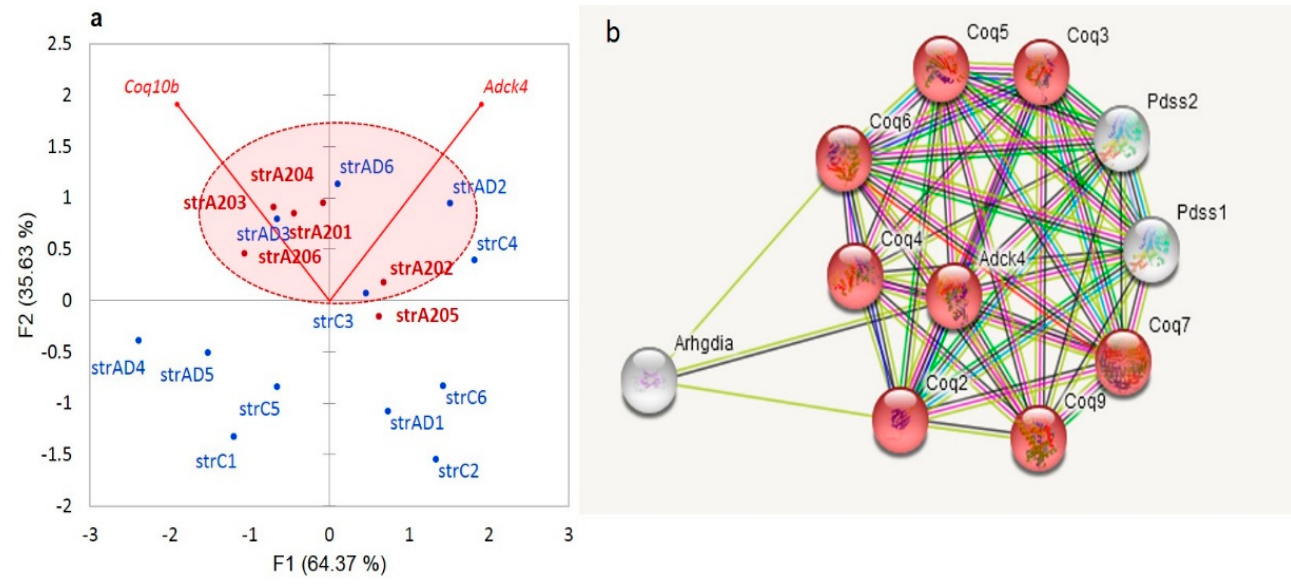
Figure 15. ( a ). The expression rate of CoQ10b , along with Adck4 ( Coq8b ), is elevated in the A20 group (encircled; random probability of five of six A20 mice located in the upper half is p < 0.01 based on a binomial test). ( b ). The gene network for Adck4 ( Coq8b ) according to string-db.org resource. Red shaded nodes relate to GO: 0005743: Mitochondrial inner membrane (8 of 435 genes; FDR < 2.2 × 10 − 9 ).